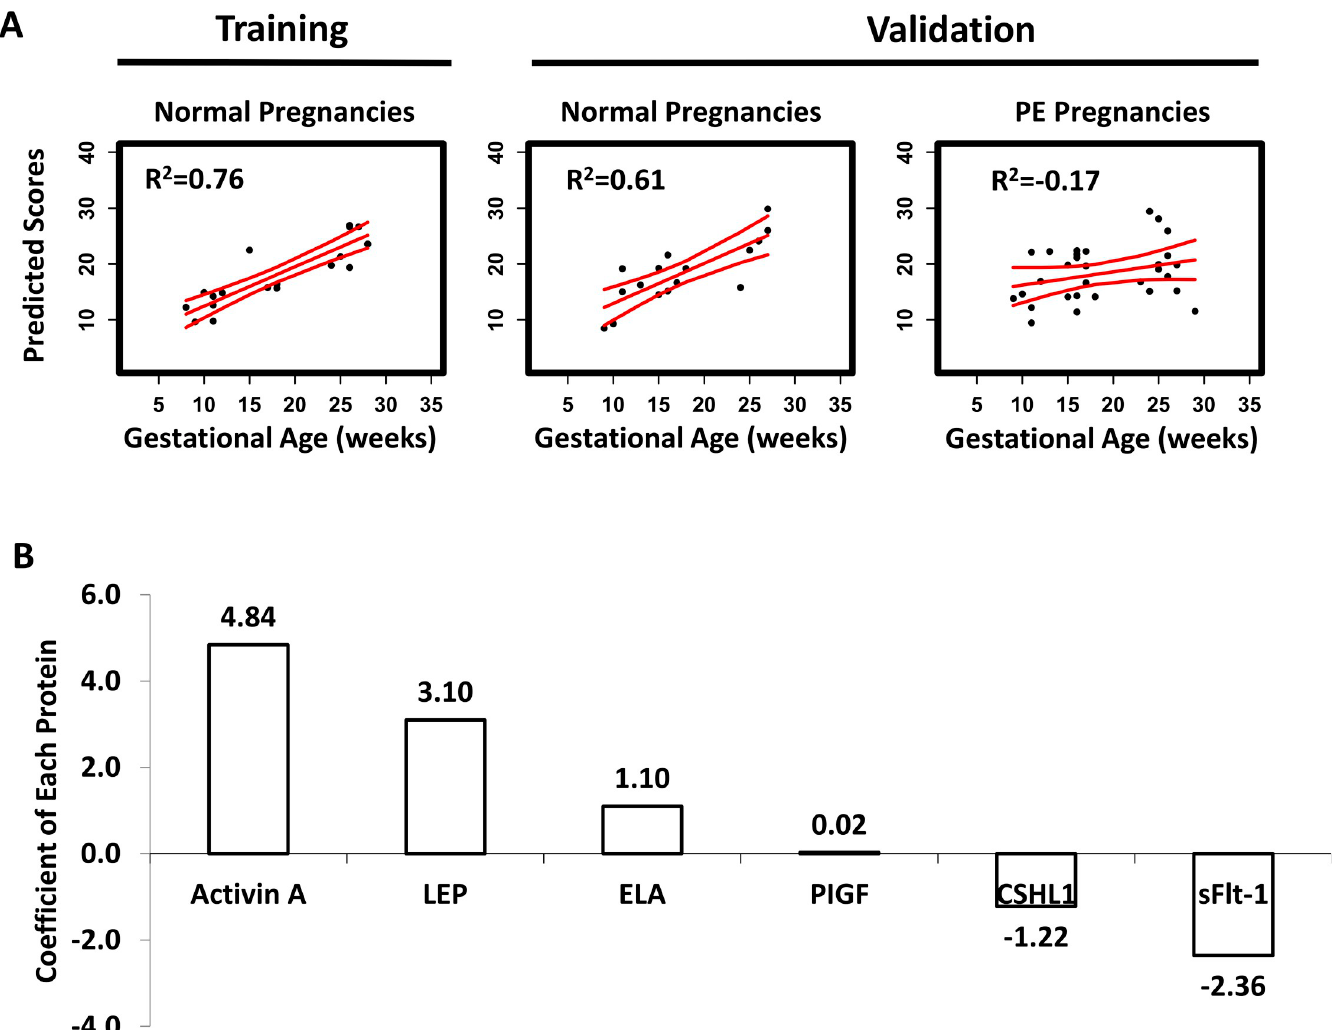
Fig 2. (A) The results of the EN model developed with serial sampling analyses of 6 placenta-related proteins, dating GAs in normal term pregnancies for both training and validation cohorts, and the results with the patients who developed PE. R 2 was calculated as 1-RSS/TSS, where RSS is a residual sum of squares, and TSS is a total sum of squares. (B) Coefficients of each protein analyte in the EN model. Positive and negative values indicate positive and negative correlations, respectively, between GA and the serum protein concentrations. Predicted scores in (A) were calculated based on the coefficients of the 6 proteins shown in